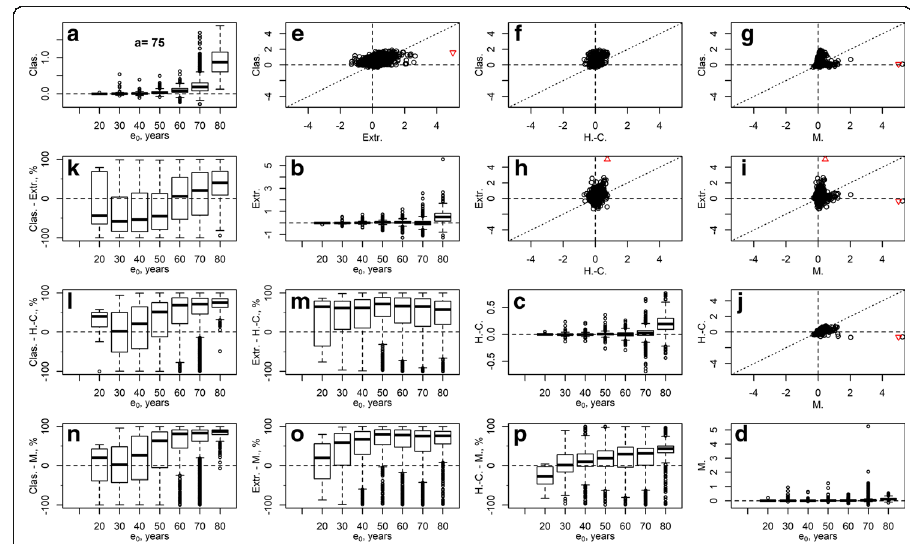
Fig. 1 Estimation errors in life expectancy at birth obtained by methods: the classical method ( “ Clas. ” ), extrapolation based on 20-years-long age base ( “ Extr. ” ), Horiuchi-Coale method ( “ H.-C. ” ), and Mitra method ( “ M. ” ). The main diagonal (plots a – d ): boxplots, as a function of life expectancy at birth, of estimation errors in each of the methods; above the diagonal (plots e – j ): scatterplots of errors in pairs of methods as indicated at axes of the plots; below the diagonal (plots k – p ): boxplots, as a function of life expectancy at birth, of percentage differences of absolute errors (5) of pairs of methods as indicated at vertical axes. Female populations, open age interval set at 75+